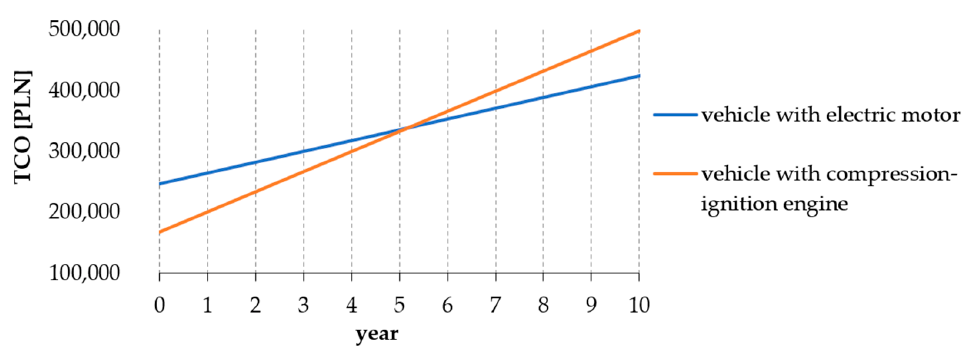
Figure 21. Total cost of ownership of vehicle during the whole operating period (vehicle is recharged only at home via an electrical socket—Scenario B1).